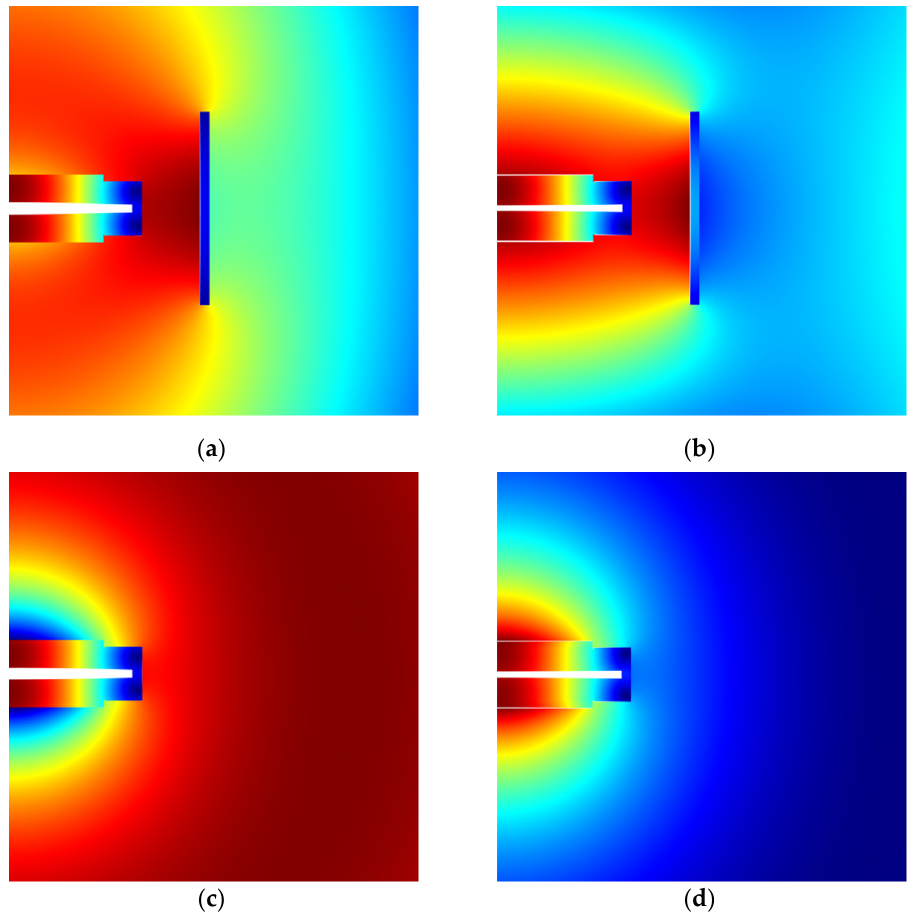
Figure 4. Sound pressure distribution and displacement (( a ) 2740 Hz with baffle, ( b ) 3700 Hz with baffle, ( c ) 2740 Hz without baffle, ( d ) 3700 Hz without baffle).